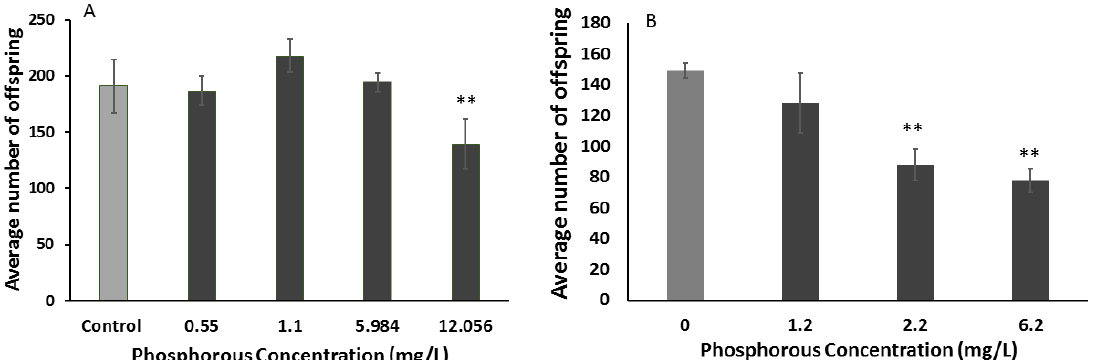
Figure 15. Effect of free phosphorene exposure over 24 h on reproduction in Caenorhabditis elegans in ( A ) K medium and ( B ) moderately hard reconstituted water (MHRW). The double asterisks indicates statistical significance at P < 0.01.